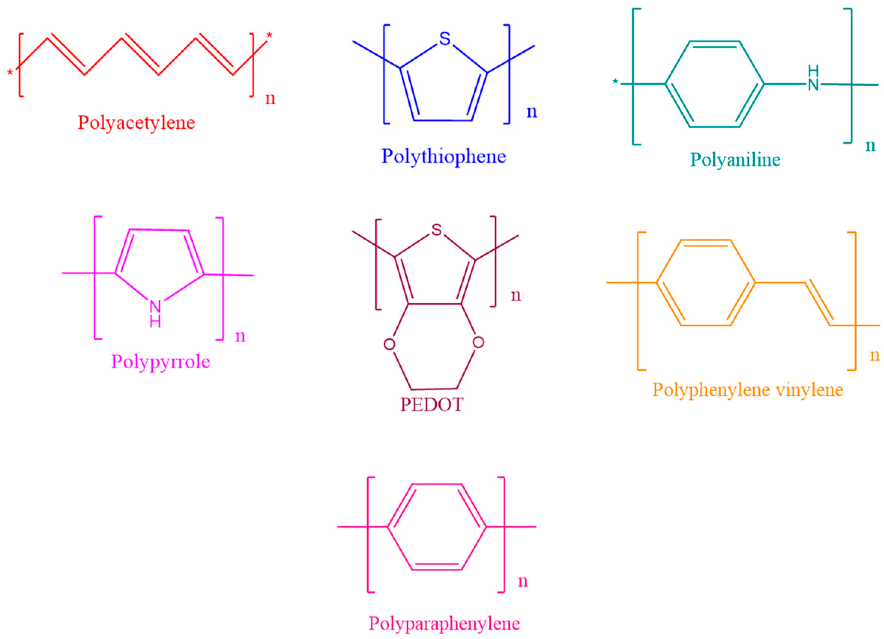
Figure 2. Structures of some common conducting